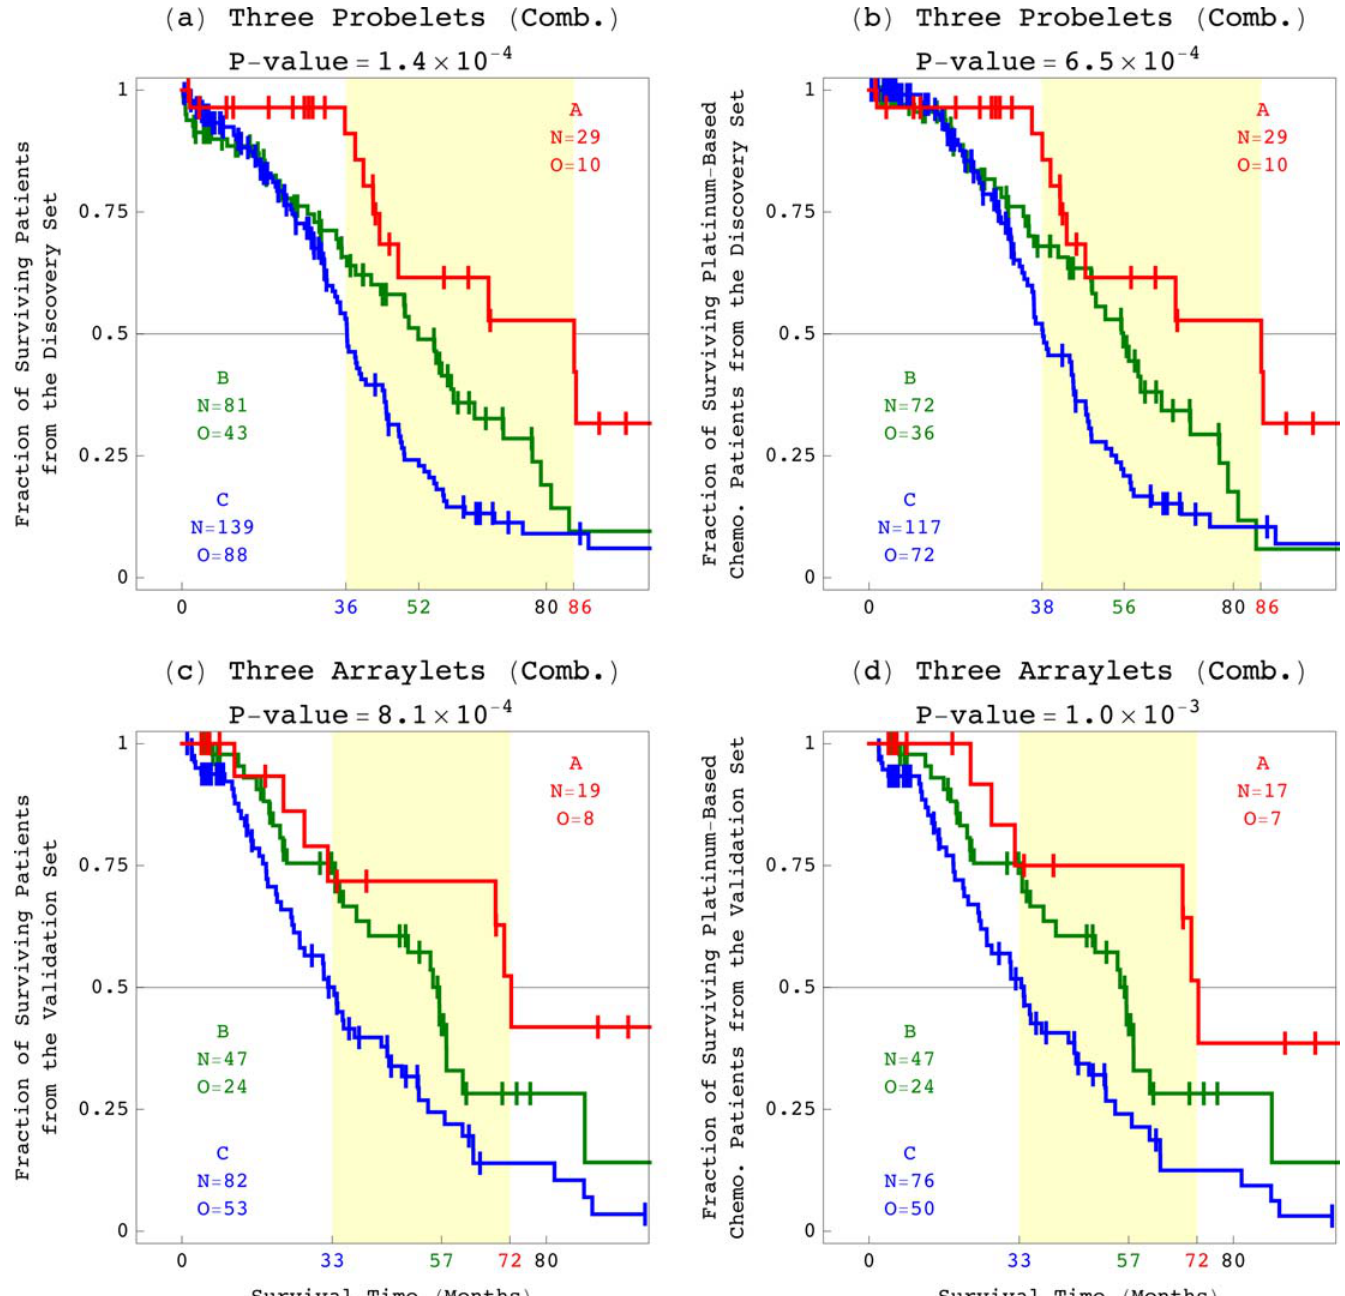
Fig 4. Survival analyses of the discovery and validation sets of patients, as well as only the platinum-based chemotherapy patients in the discovery and validation sets, classified by the 6p+12p, 7p, and Xq tensor GSVD combined. ( a ) KM curves of the discovery set of 249 patients classified by combination of the 6p+12p, 7p, and Xq x -probelet coefficients, show median survival times of 86, 52, and 36 months for the groups A, B, and C, respectively, with the corresponding log-rank test P -value < 10 − 3 . ( b ) KM survival analysis of only the 218, i.e., * 88% platinum-based chemotherapy patients in the discovery set, classified by combination of the three tensor GSVDs, gives qualitatively the same and quantitatively similar results to those of the analyses of 100% of the patients. This means that the combination of the three tensor GSVDs predicts survival in the platinum-based chemotherapy patient population. ( c ) KM curves of the validation set of 148 stage III-IV patients classified by combination of the 6p+12p, 7p, and Xq arraylet correlation coefficients, show median survival times of 72, 57, and 33 months for the groups A, B, and C, respectively, with the corresponding log-rank test P -value < 10 − 3 . This validates the survival analyses of the discovery set of 249 patients. ( d ) KM survival analysis of only the 140, i.e., * 95% platinum-based chemotherapy patients in the validation set, classified by combination of the three tensor GSVDs.